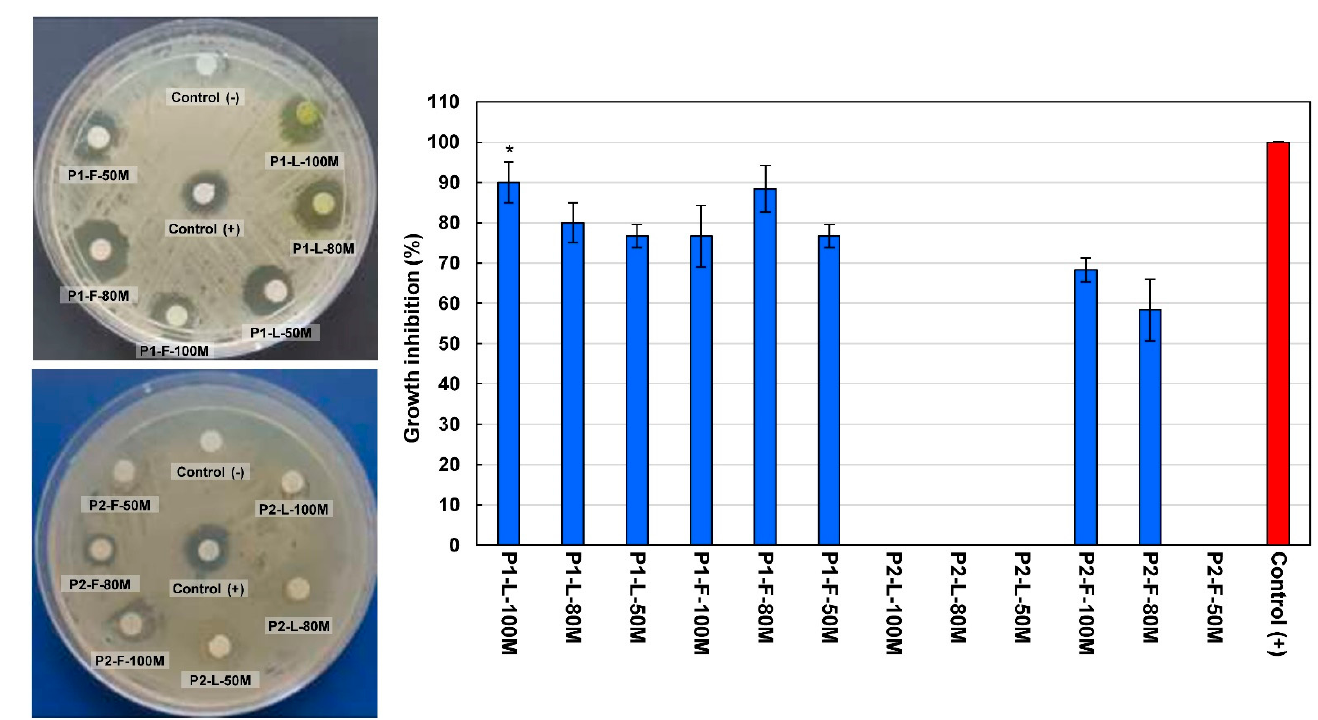
Figure 5. Antibacterial activity of methanolic extracts from Verbesina sphaerocephala leaves and flowers against Staphylococcus aureus . Values are expressed as mean ± standard deviation of three repetitions. Abbreviations: P1, Population 1; P2, Population 2; L, leaves; F, flowers; 100M, extracted with 100% methanol; 80M, extracted with 80% methanol; 50M, extracted with 50% methanol; Control (+), ampicillin 10 mg/mL; Control (-), methanol/DMSO. (*) Indicates no significant statistical difference from the control according to Dunnett’s test ( p <